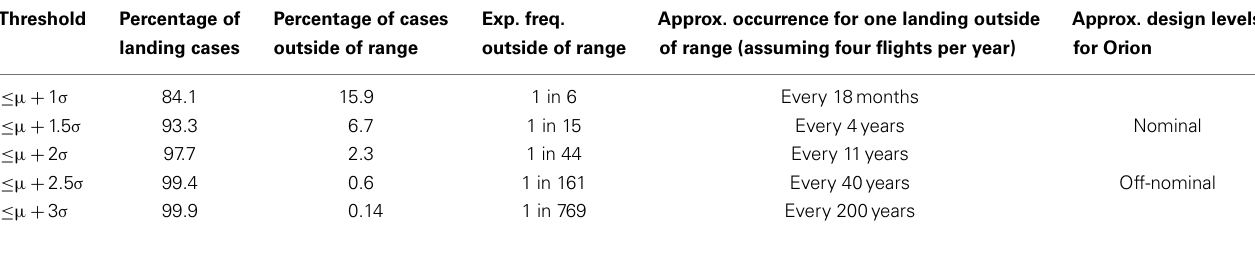
Table 1 | Comparison of possible nominal and off-nominal distribution